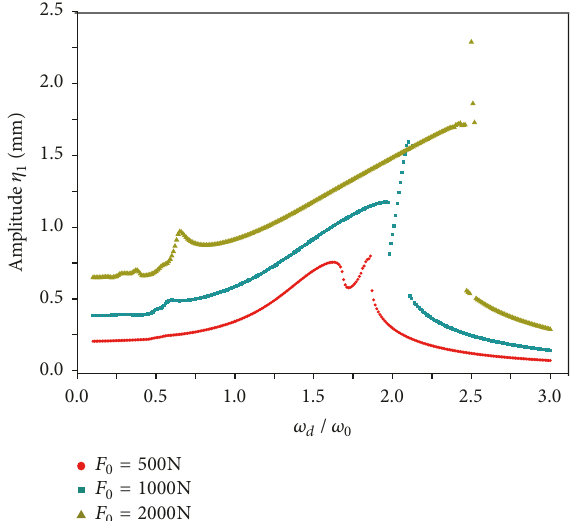
Figure 7: Comparison of the amplitude-frequency response between original model and reduced model ( 𝑚 = 1 , 𝑛 = 4 ; Ω = 0.005 ; 𝐹 = 2000 N). 0